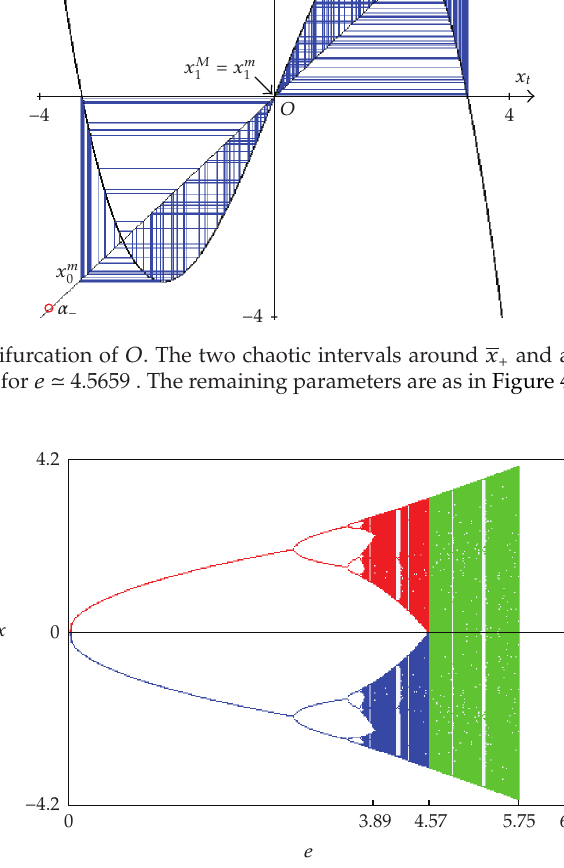
Figure 6: Bifurcation diagram versus parameter e for the one-dimensional model, under the basic parameter setting: d (cid:8) 0 . 35 and f (cid:8) 0 . 7. The homoclinic bifurcation of the two symmetric fixed points occurs at e (cid:4) 3 . 89, the reunion of the two disjoint intervals, homoclinic bifurcation of the origin, at e (cid:4) 4 . 5659, while the final bifurcation occurs at e (cid:8) e f (cid:4) 5 .